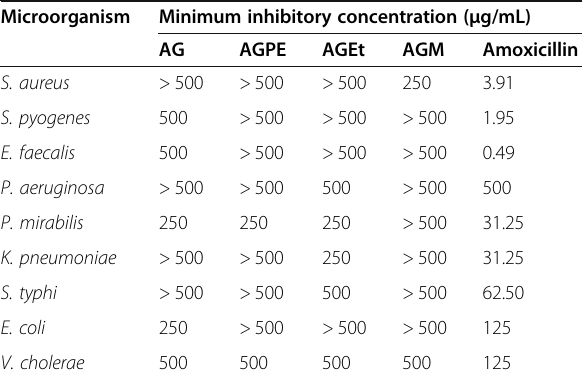
Table 2 MICs of A. genipiflora stem bark extract and fractions against clinically significant bacteria in HTSPOTi assay Microorganism